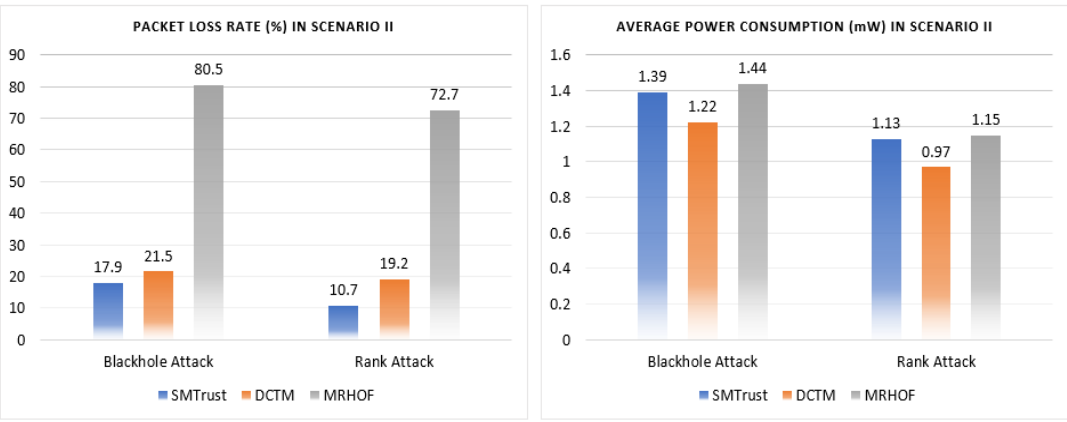
Figure 7. Results comparison of network performance under Blackhole and Rank attack in Scenario II.